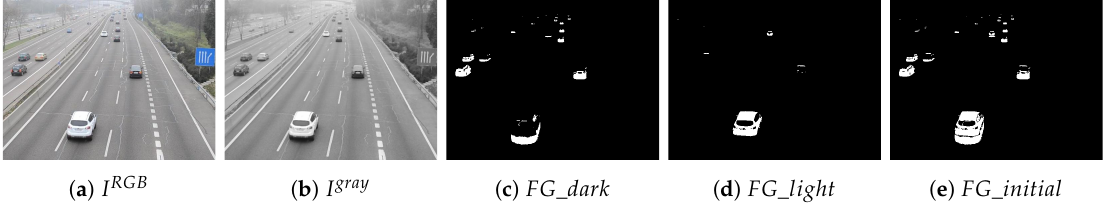
Figure 6. The extraction of the initial foreground on a cloudy